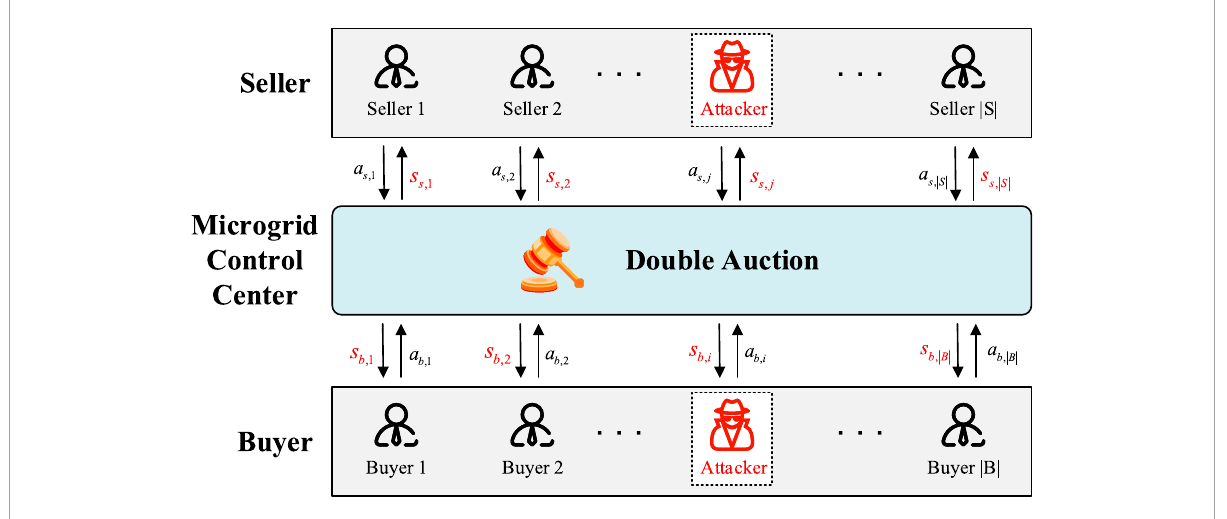
FIGURE 3 Adversarial attacks in electricity